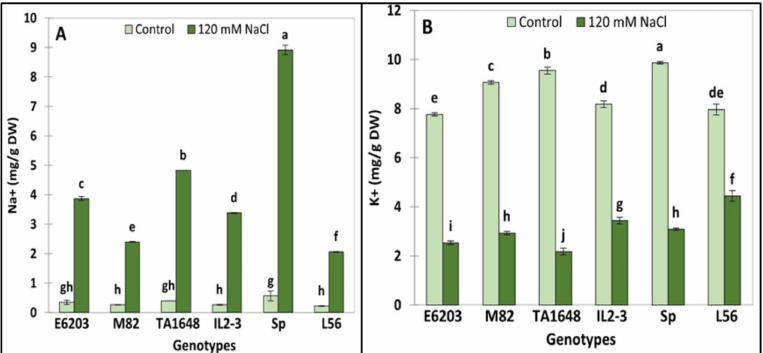
Figure 5. Ions (Na + and K + ) accumulation under control and salt stress (120 mM NaCl) in leaves of two ILs (TA1648 and IL2-3), the cultivar parents (cv. E6203 and M82), and two salt-tolerant reference genotypes, “SP” (wild type) and “L56” (fixed variety). ( A ) Sodium concentration (Na + ), ( B ) Potassium concentration (K + ). Values are expressed as means ± SD of three plants per genotype. Different letters indicate statistically significant differences according to Duncan’s test ( p <